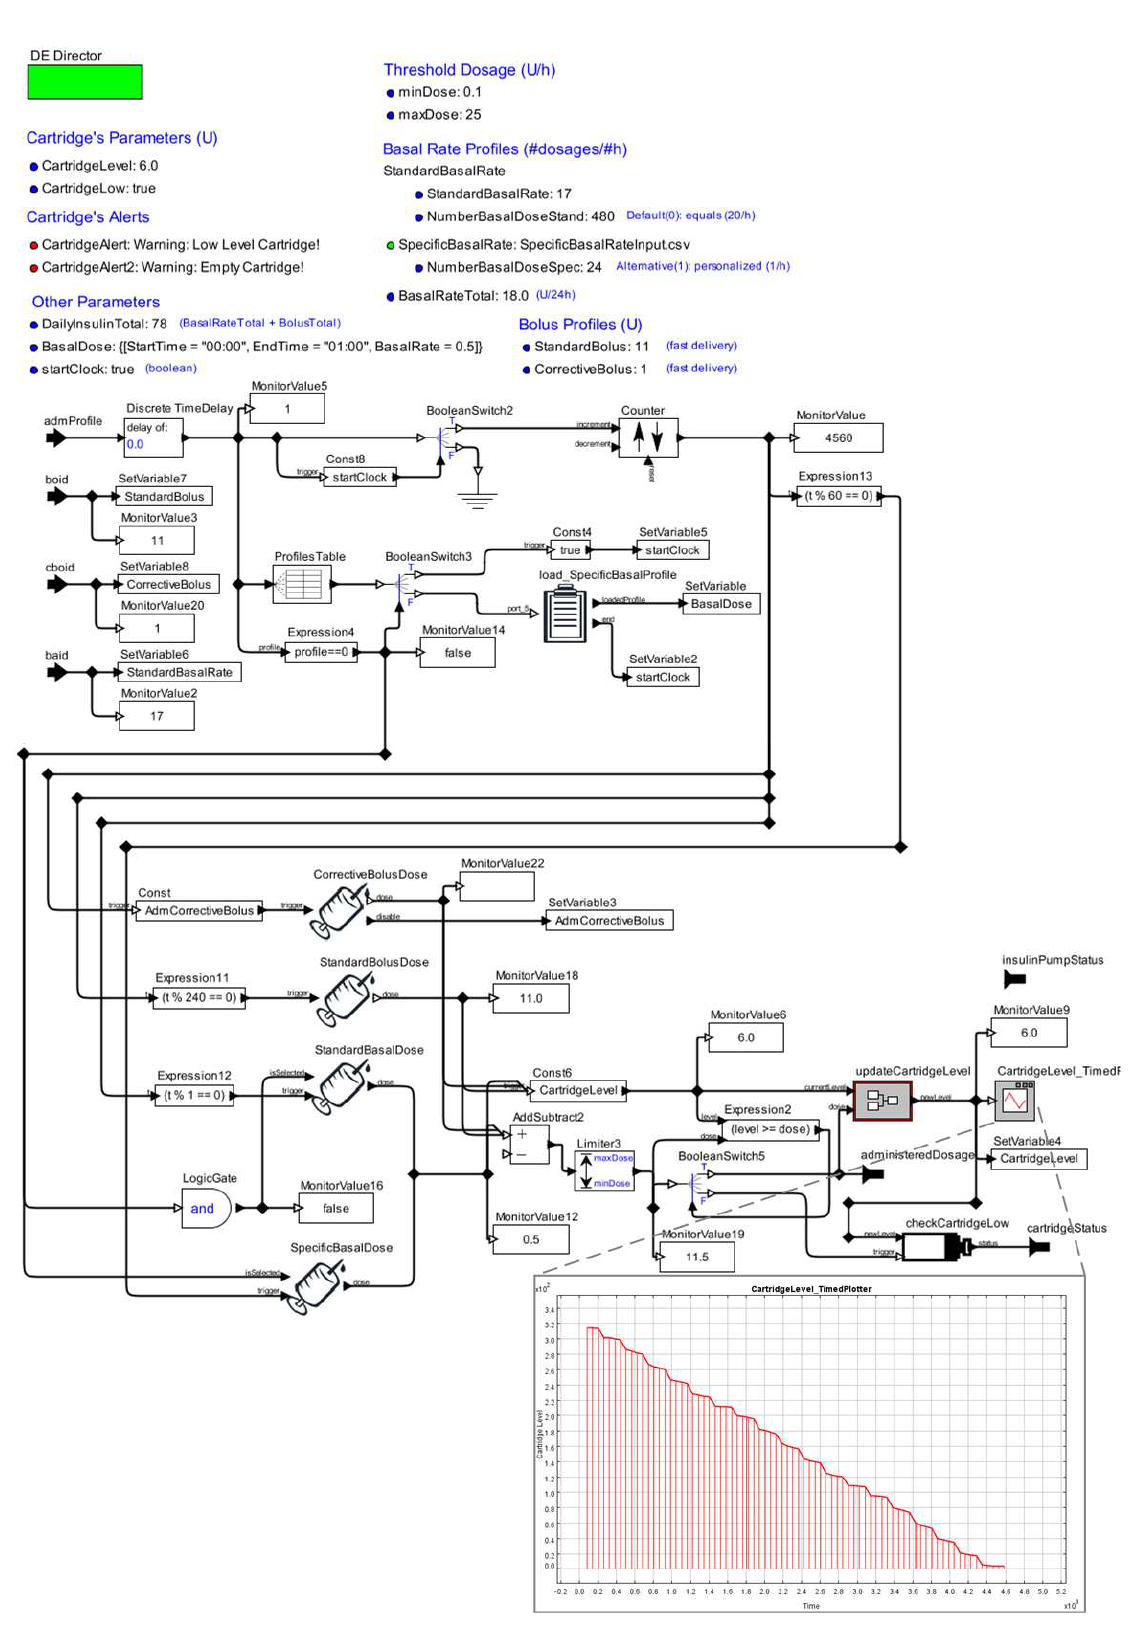
Figure 10. State’s Refinement of the Insulin Pump